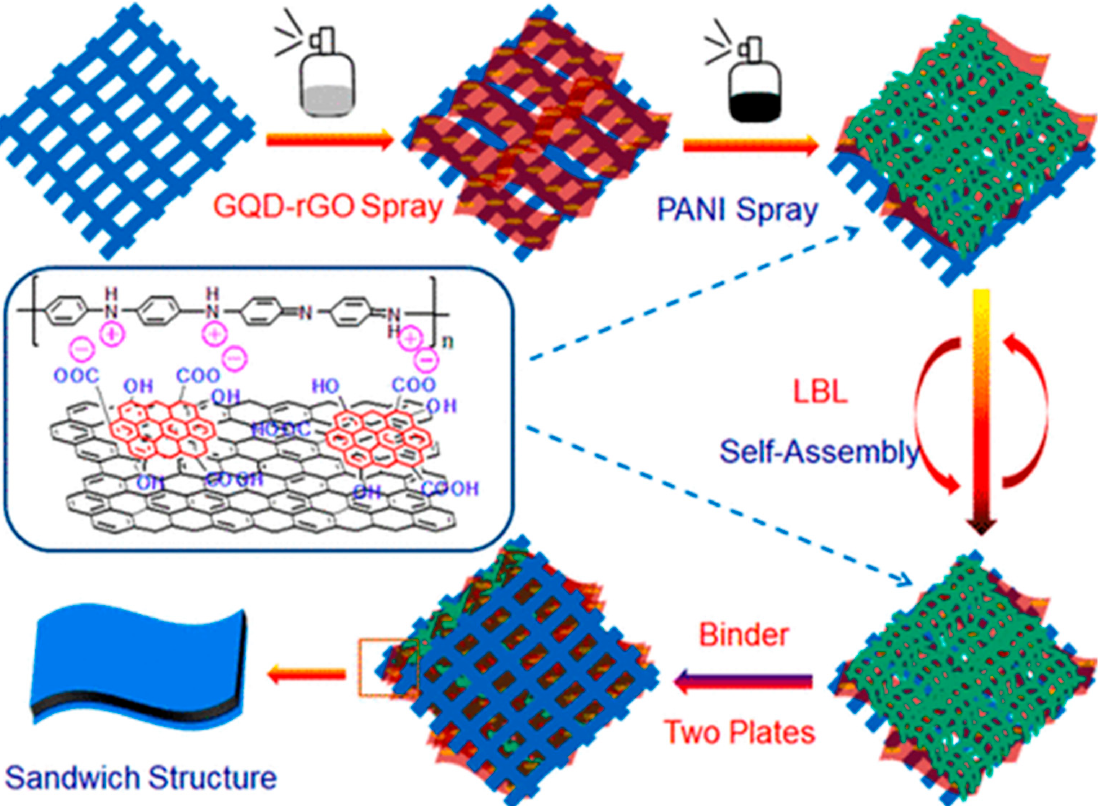
Figure 21. Layer-by-layer assembly of GQD-rGO and PANI over CFC for the formation of a supercapacitor electrode. The inset picture shows the interaction between GQD-rGO and PANI. Reprinted with permission from Ref. [169].